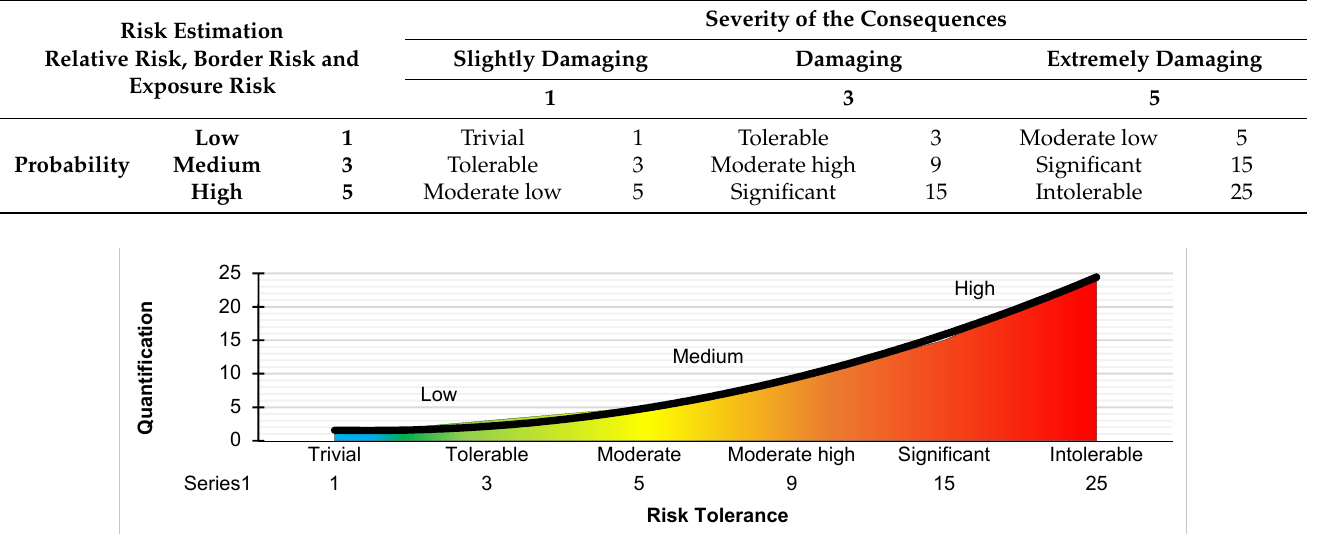
Figure 2. Characteristic values graphic: relative risk, border risk and exposure risk. Table 4. Characteristic values: economic capacity, participative interest and satisfaction level.